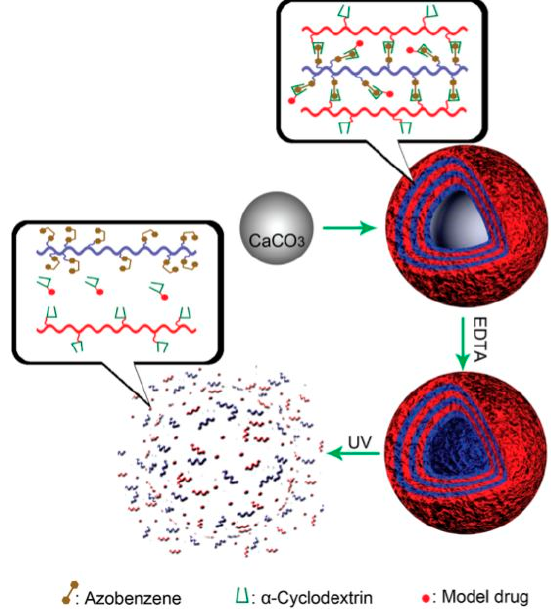
Figure 6. Capsules structure and release mechanism of α -CD/Azo LbL microcapsules as depicted by